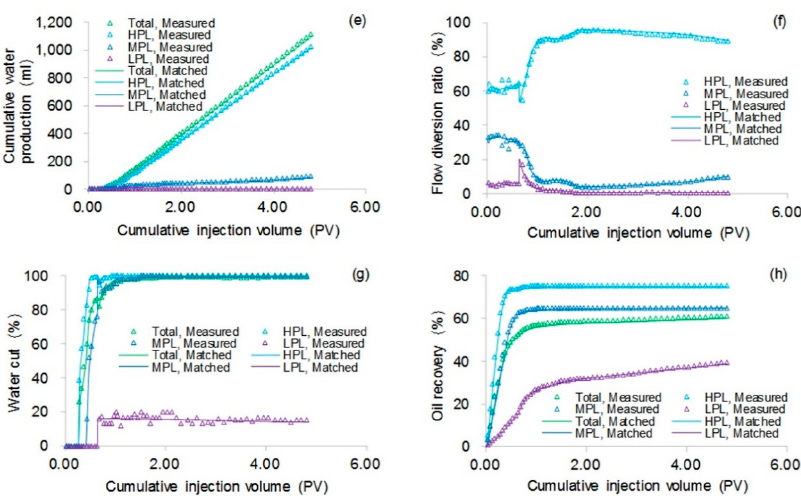
Figure 12. Comparison results in terms of: ( a ) pressure difference, ( b ) oil production, ( c ) water production, ( d ) cumulative oil production, ( e ) cumulative water production, ( f ) flow diversion ratio, ( g ) water cut, and ( h ) oil recovery of the polymer flooding experiment obtained by the designed simulator in simulating the polymer flooding experiment.